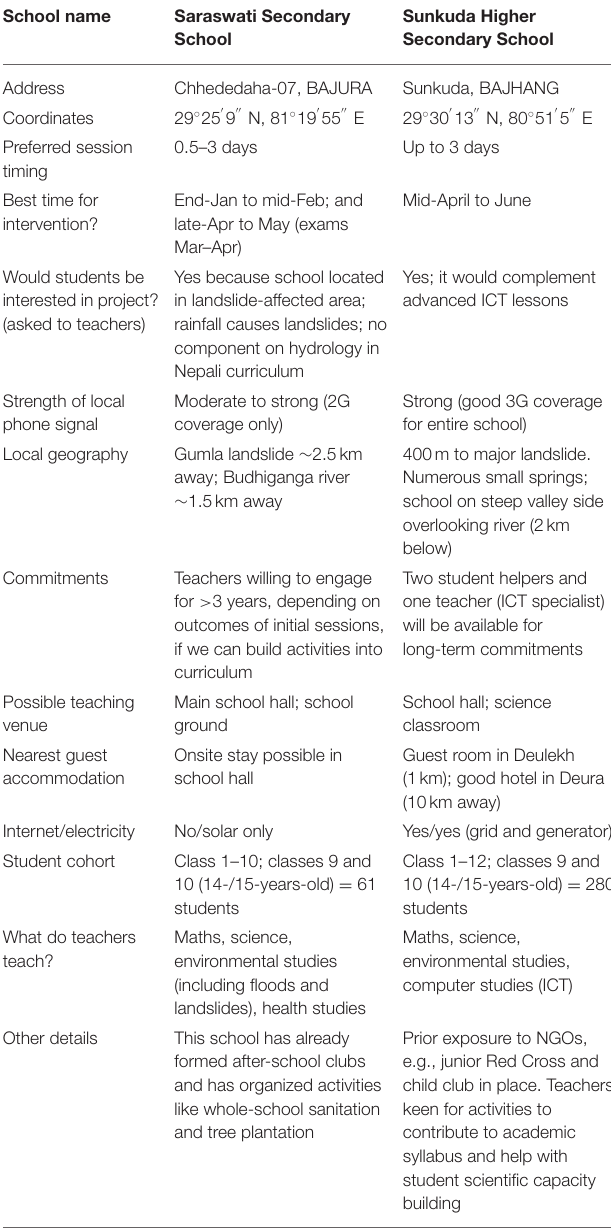
TABLE 1 | Information relating to each school, sourced a priori